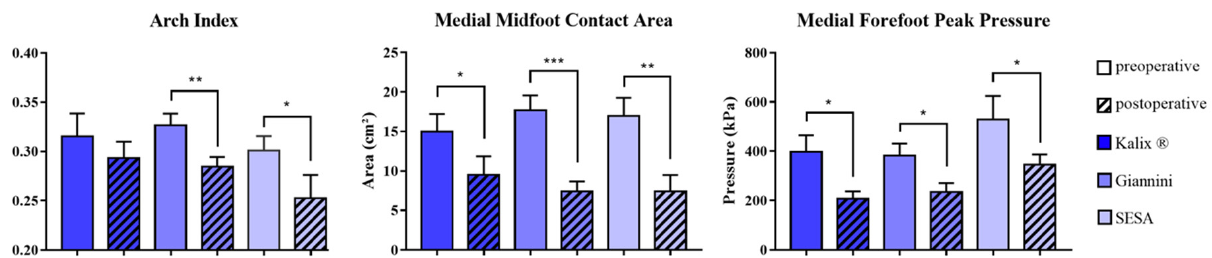
Figure 8. Pre- and postoperative pedobarographic measurements depending on the used implant type. Arch index ( left ), medial midfoot contact area ( center ) and medial forefoot peak pressure ( right ) are shown. ( µ ± SEM, Wilcoxon signed-rank test, * = p < 0.05, ** = p < 0.01, *** = p < 0.001). SESA: subtalar extraarticular screw arthroereises.